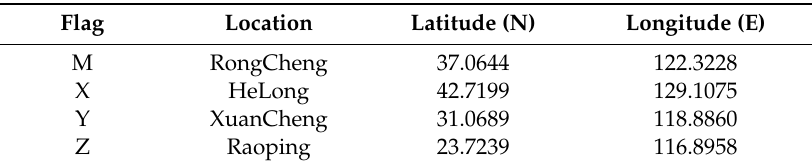
Table 1. Location of sites used in the calculation.